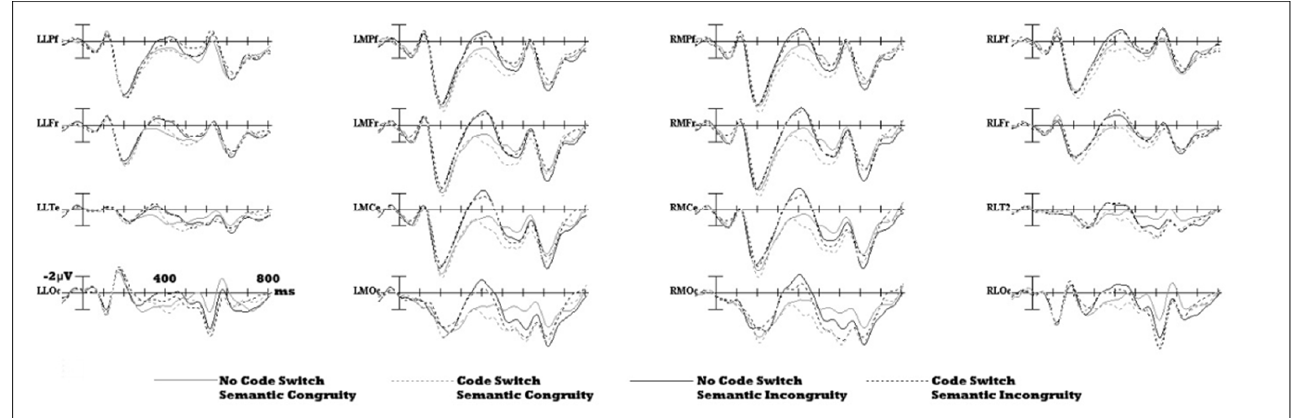
Figure 1. ERP waveforms. Raw waveforms are presented for each condition, time-locked to the onset of each stimulus.